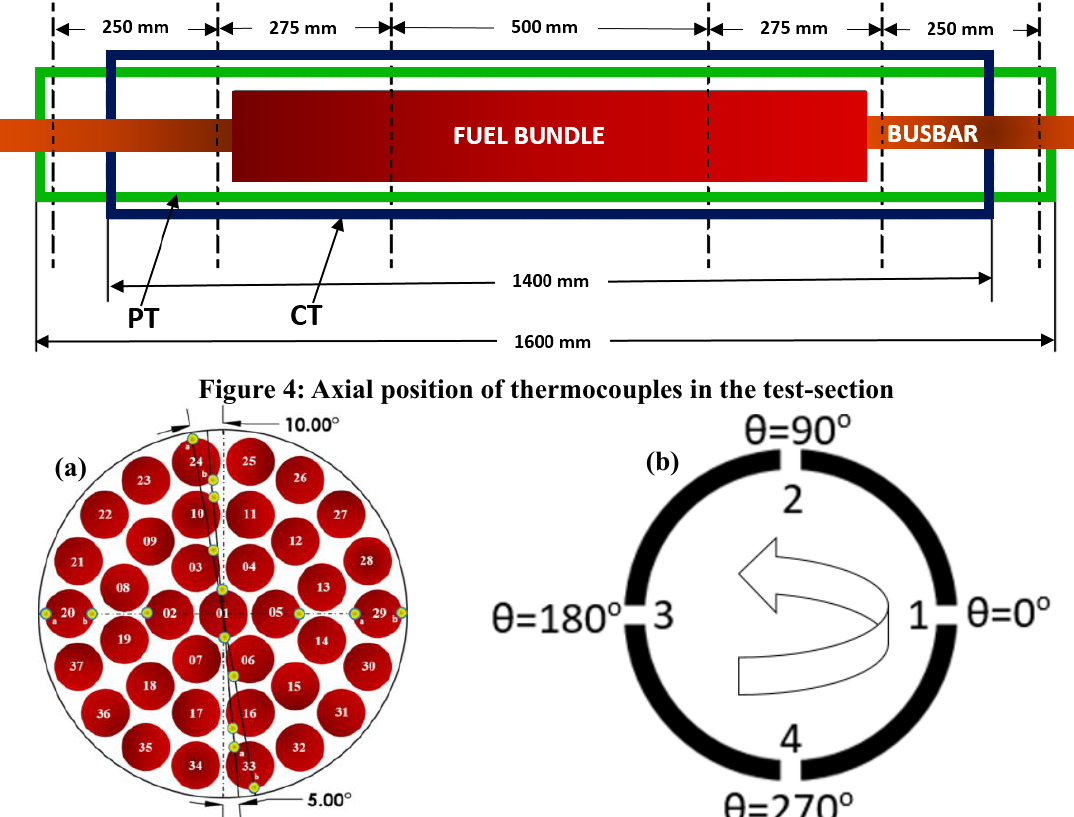
Figure 4: Axial position of thermocouples in the test-section